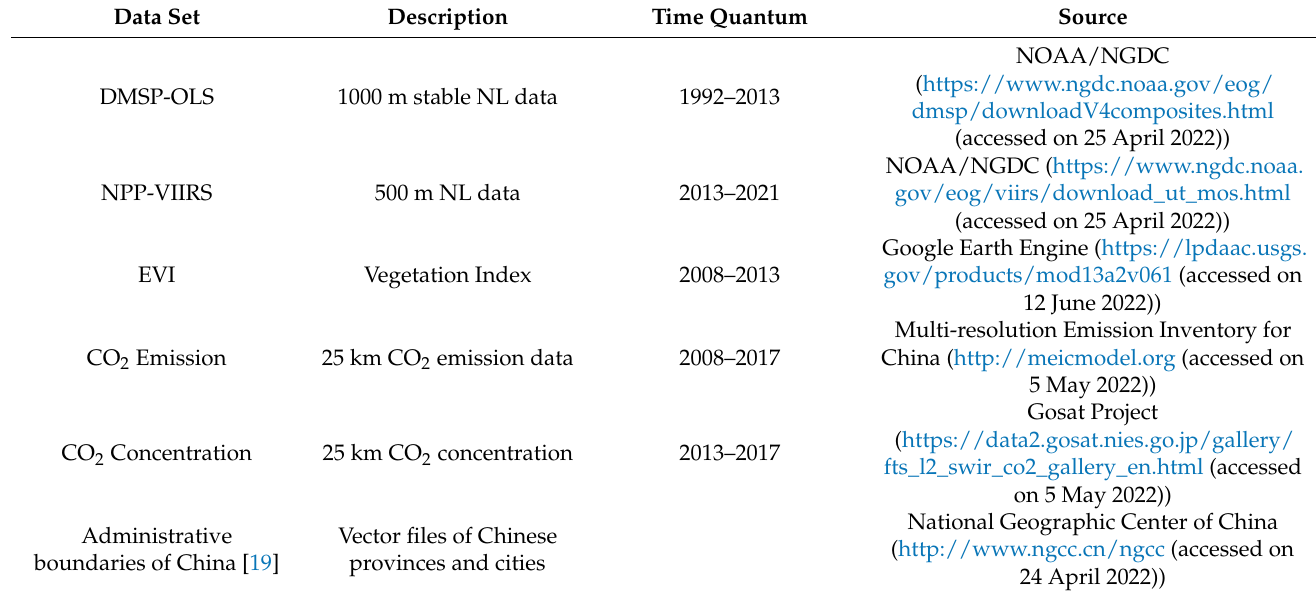
Table 1. Description of the data used in the study.